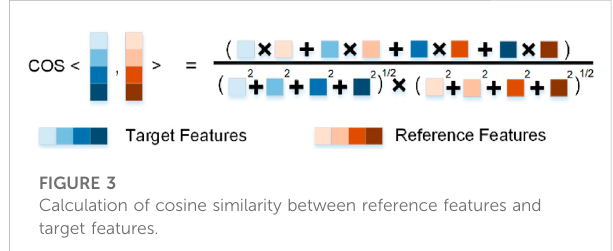
FIGURE 3 Calculation of cosine similarity between reference features and target features.